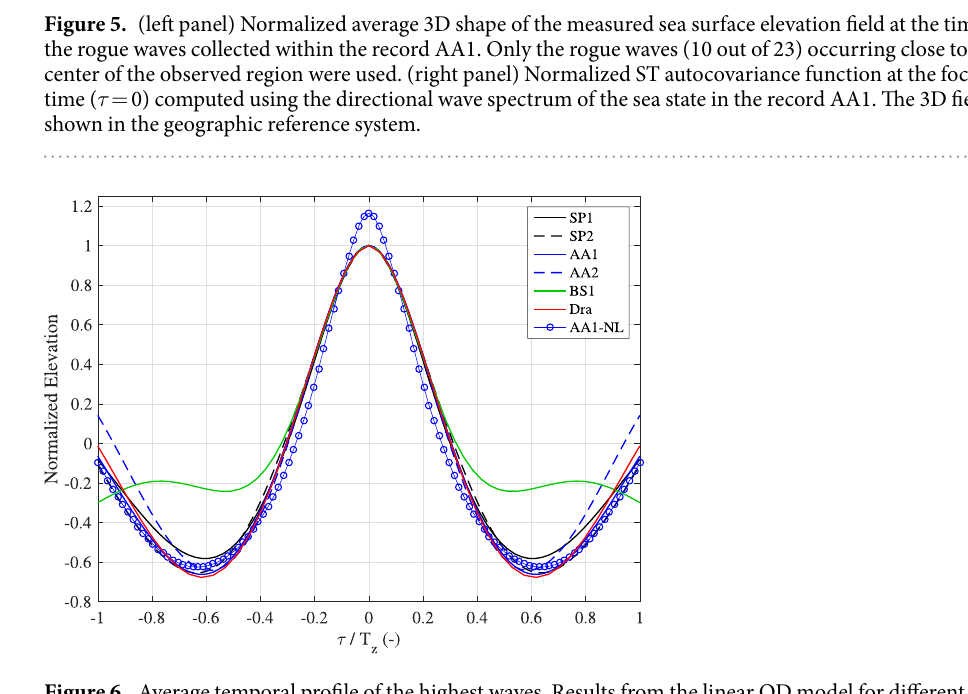
Figure 6. Average temporal profile of the highest waves. Results from the linear QD model for different sea conditions (Fig. 1 and Table 1). The second-order nonlinear profile for the record AA1 is also shown